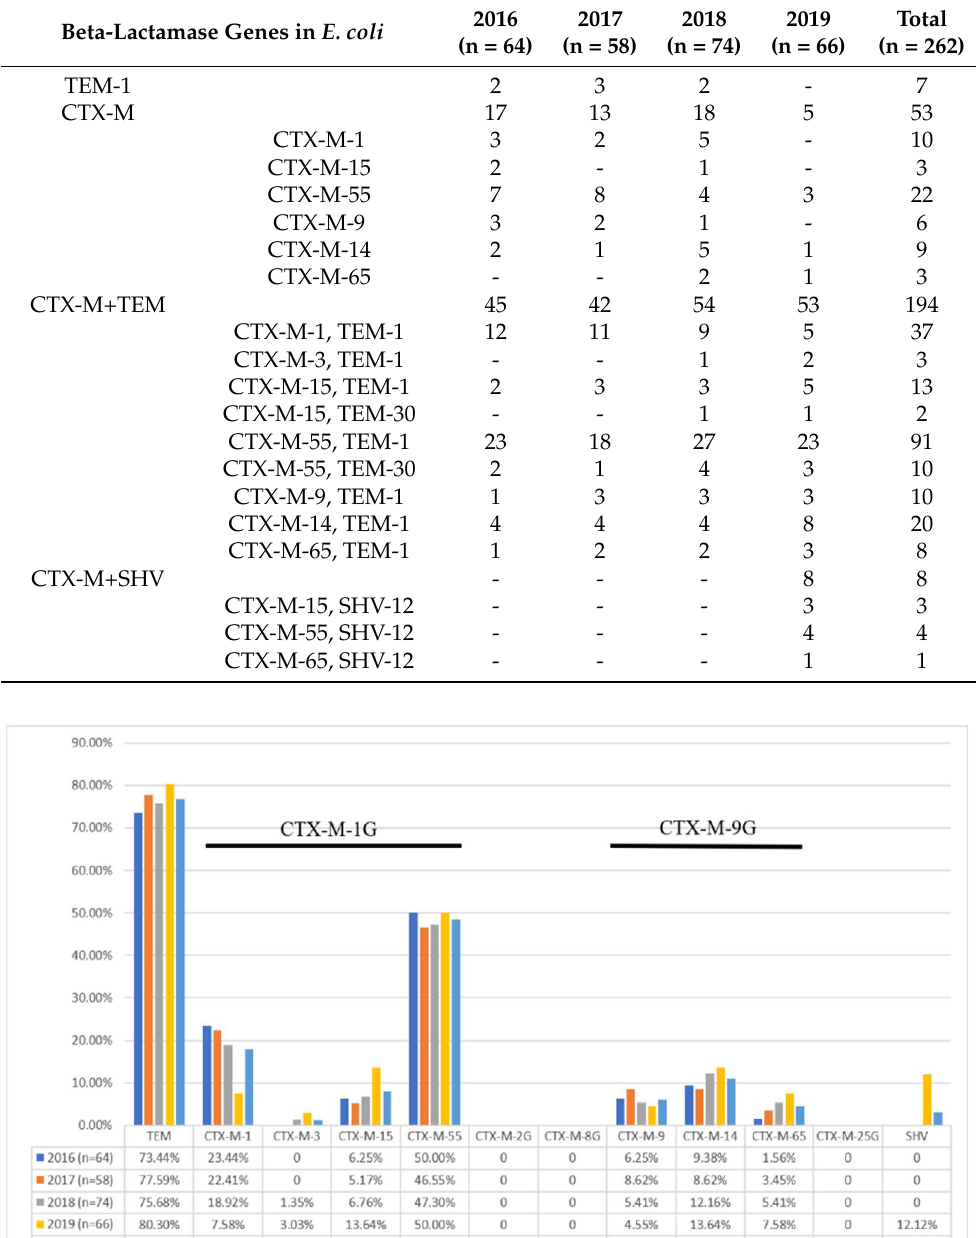
Table 3. Frequency and combinations of ESBL genes among in ESBL-producing E. coli (n = 262). Beta-Lactamase Genes in E. coli